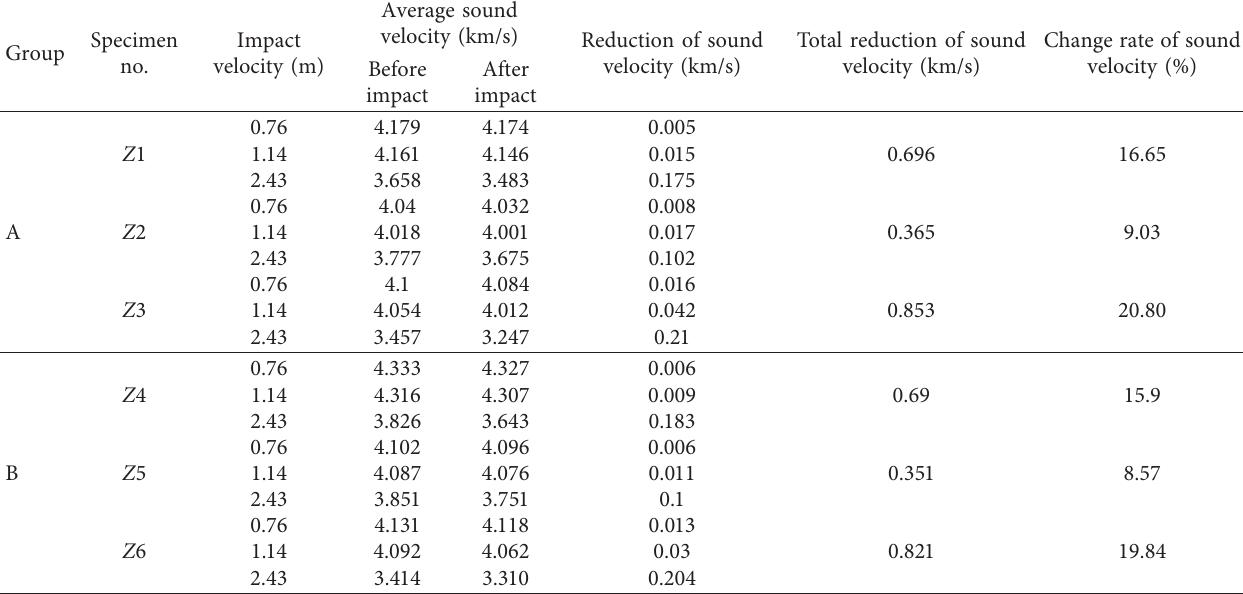
Table 8: Changes in the ultrasonic velocities of the concrete